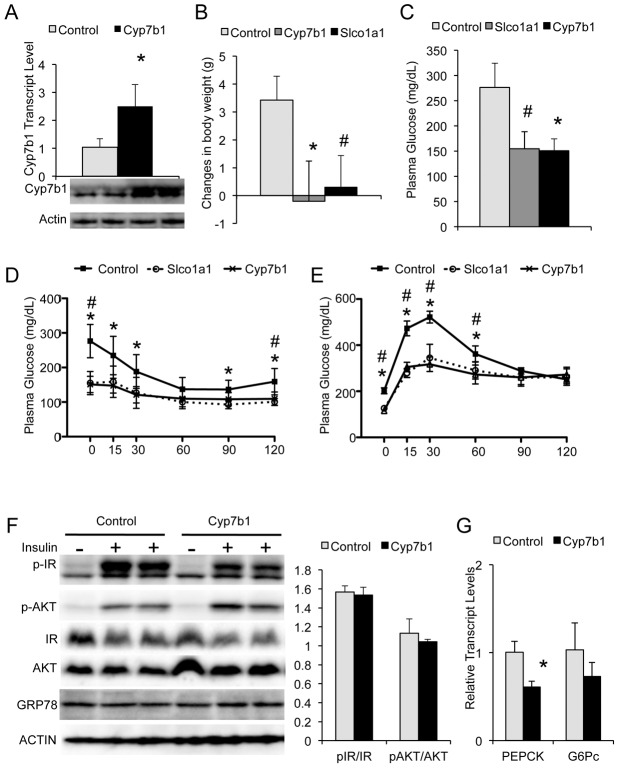
Cyp7b1 and Slco1a1 overexpression regulates glucose homeostasis. (A) Examination of Cyp7b1 expression in the liver of ob/ob mice transduced with control and Cyp7b1 over-expressing adenoviruses by quantitative RT-PCR and immunoblot analysis. (B) Changes of body weight in control and Cyp7b1 and Slco1a1 overexpressing mice in a 14 day period post-virus injection. (C) Glucose levels of control and experimental mice 5 days post-virus injection. (D–E) Insulin and glucose tolerance test of control and experimental mice with bolus injections of insulin (1.0 IU/kg) or glucose (0.75 g/kg) and measurement of plasma glucose levels at indicated times (n = 9). (F) Immunoblot analysis of insulin signaling stimulated by portal vein injection as indicated by insulin receptor (IR) and AKT phosphorylation. The graph on the right side shows the quantitation of the data after correction for total protein amount. (G) Expression of gluconeogenic genes in the liver of control and experimental mice as measured by with real time, quantitative RT-PCR (n = 4). “*” denotes p<0.05 comparing control versus Cyp7b1-overexpressing mice, and “#” denotes p<0.05 comparing control versus Slco1a1 overexpression, Student's t-test. PEPCK: phosphoenolpyruvate carboxykinase; G6Pc: Glucose-6-phosphatase catalytic subunit.